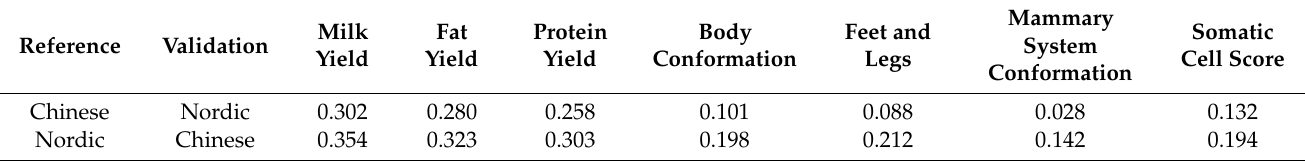
Table 5. Accuracy of the younger individuals in the cross population